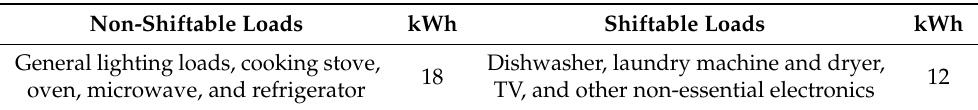
Table 2. Energy consumption of a single-family household per